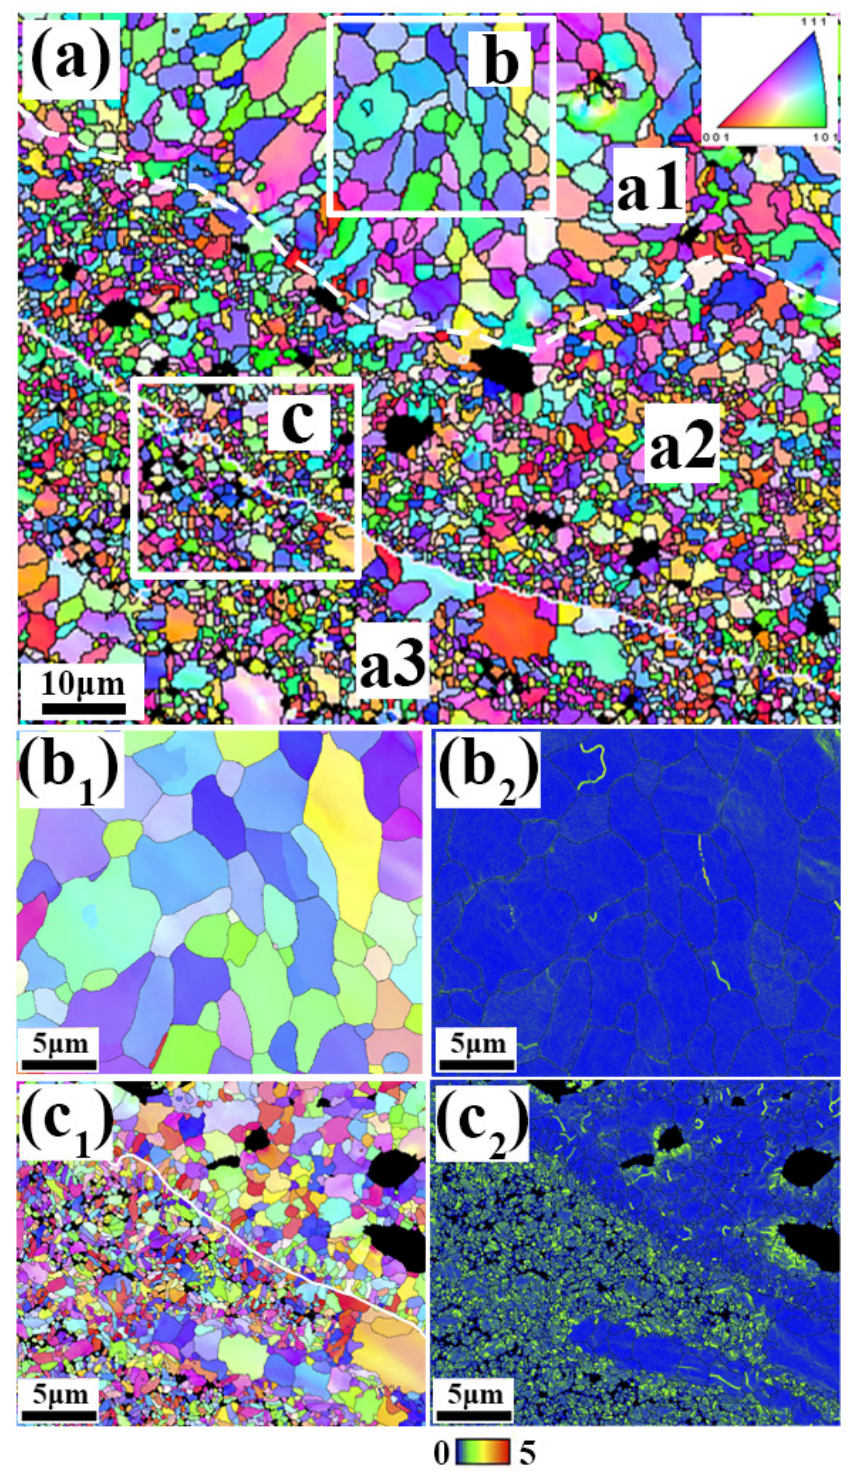
Figure 4. Microstructural analysis of the residual jet after penetration via EBSD: ( a ) IPF map of microstructures marked in rectangle in Figure 3b; ( b 1 , b 2 ) IPF map and corresponding KAM map of region b in ( a ); ( c 1 , c 2 ) IPF map and corresponding KAM map of region c in ( a ). The dashed line in ( a ) represents the boundary between regions a1 and a2, and the white solid line indicates the steel target (region a3) and residual jet (regions a1 and